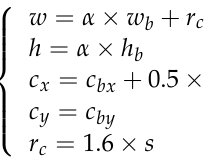
scenes since the center and size of the pipeline remains the same during one pipeline period.